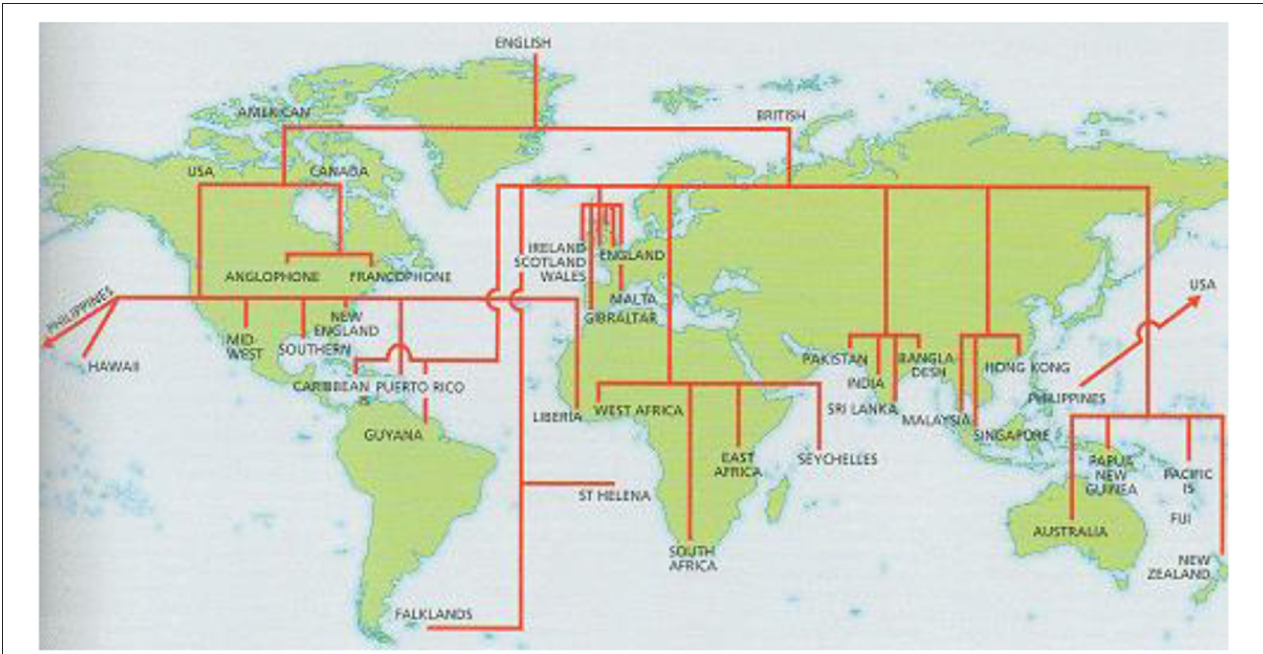
FIGURE 1 | Strevens’s Geo-political Map of world Englishes (from Crystal, 1995, p. 107, redrawn from Strevens,